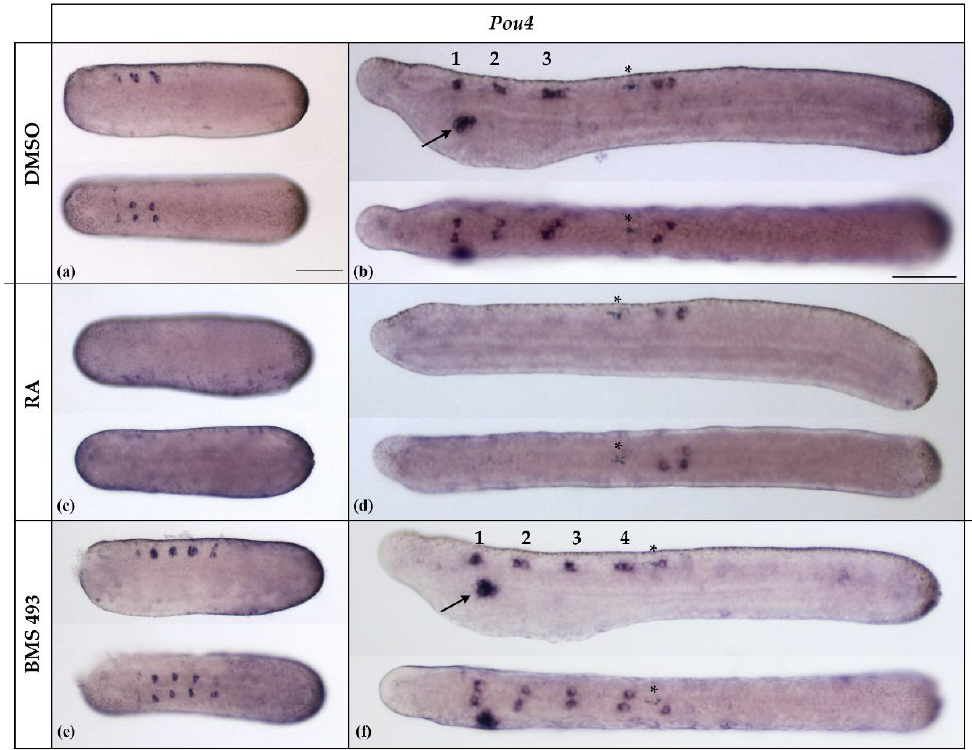
Figure 6. Expression of Pou4 in N4- and T1-stage Branchiostoma lanceolatum embryos. ( a , b ) Control embryos (DMSO-treated). ( c , d ) Retinoic acid (RA) signaling activation with all- trans retinoic acid (RA). ( e , f ) RA signaling inhibition with the inverse agonist BMS493. In N4-stage neurulae, Pou4 was expressed in three pairs of neurons in the anterior nerve cord and scattered ectodermal sensory neurons ( a ). At this stage, Pou4 expression was completely lost in the nerve cord following RA treatment ( c ), while BMS493 treatments induced supernumerary pairs of Pou4 -positive cells in the nerve cord ( e ). At the T1 stage ( b , d , f ), Pou4 was further expressed in a variable number of neural cells posterior to the first pigment spot (asterisks) and in the mouth primordium (arrow). Pou4 expression in the mouth primordium was lost in RA-treated embryos ( d ) and maintained in BMS493-treated embryos ( f ). Whole mount embryos are shown in lateral (top) and dorsal (bottom) views; the anterior is to the left. The scale bar in ( a ) is 50 μm and is valid for panels ( a , c , e ); the scale bar in ( b ) is 50 μm and is valid for panels ( b , d , f ).